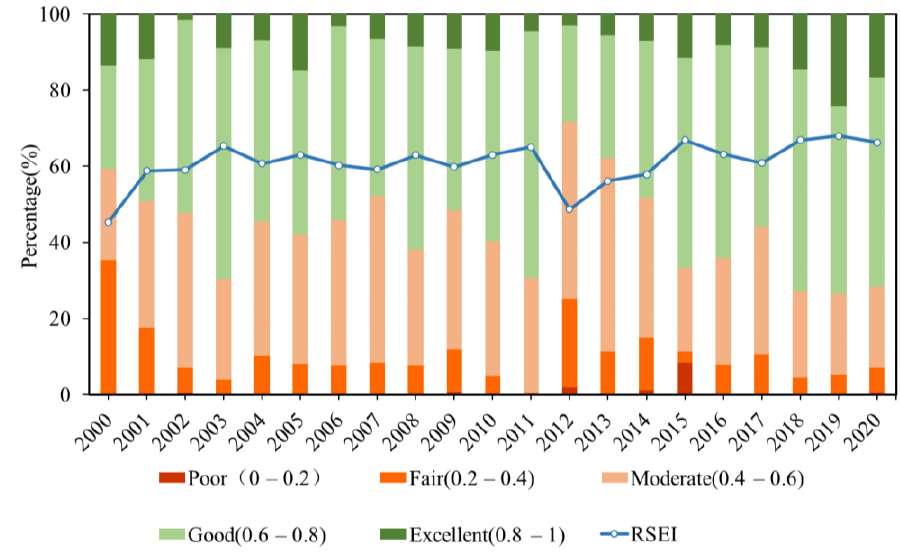
Figure 6. Percentage of RSEI classes and changed in RSEI between years.